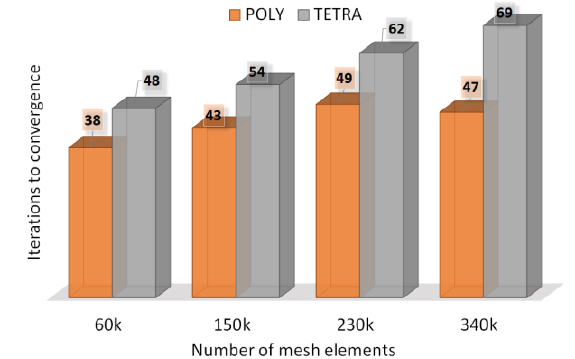
Fig. 6. Number of iterations to convergence of the analysed cases